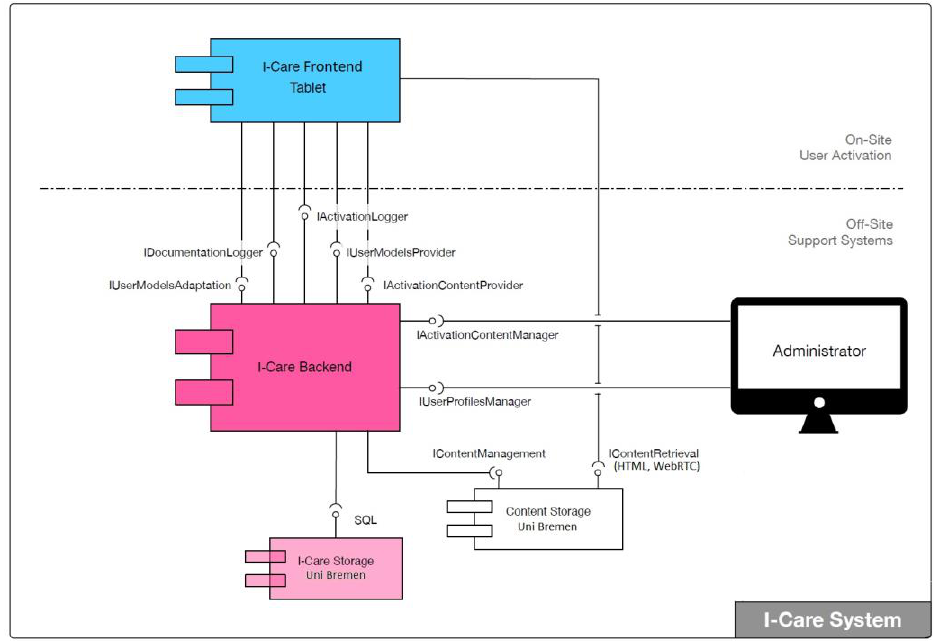
Figure 3. The I-CARE system